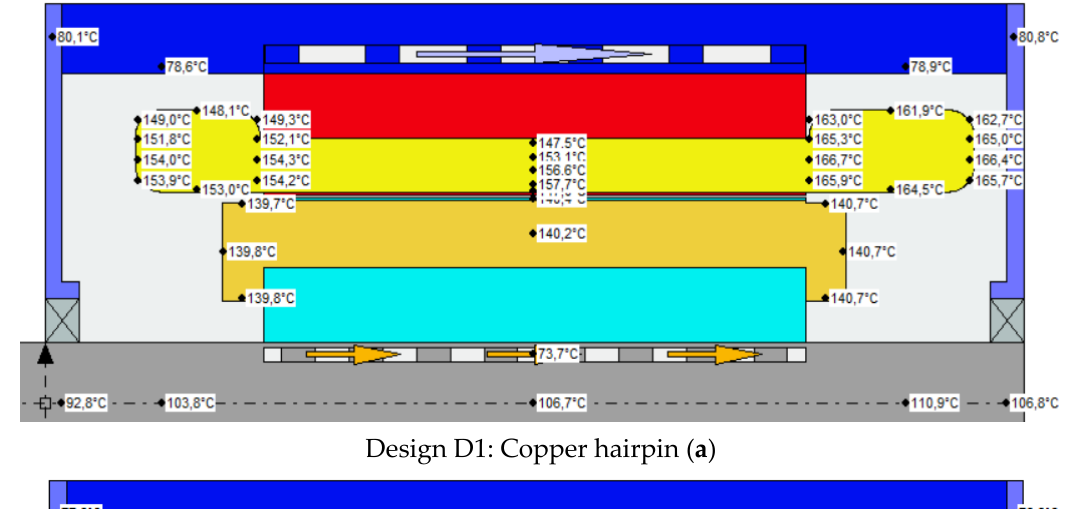
8 of 20 Figure 3. Flux density and flux isoline distribution: ( a ) design D1; ( b ) design D2; ( c ) design D3. At the same time, the steady-state thermal analysis is carried out to evaluate the maximum temperature reached during continuous operation considering the different stack lengths, the higher thermal conductivity of copper compared to aluminum in the windings, and the consequent better ability to transport heat from the slot to the core.